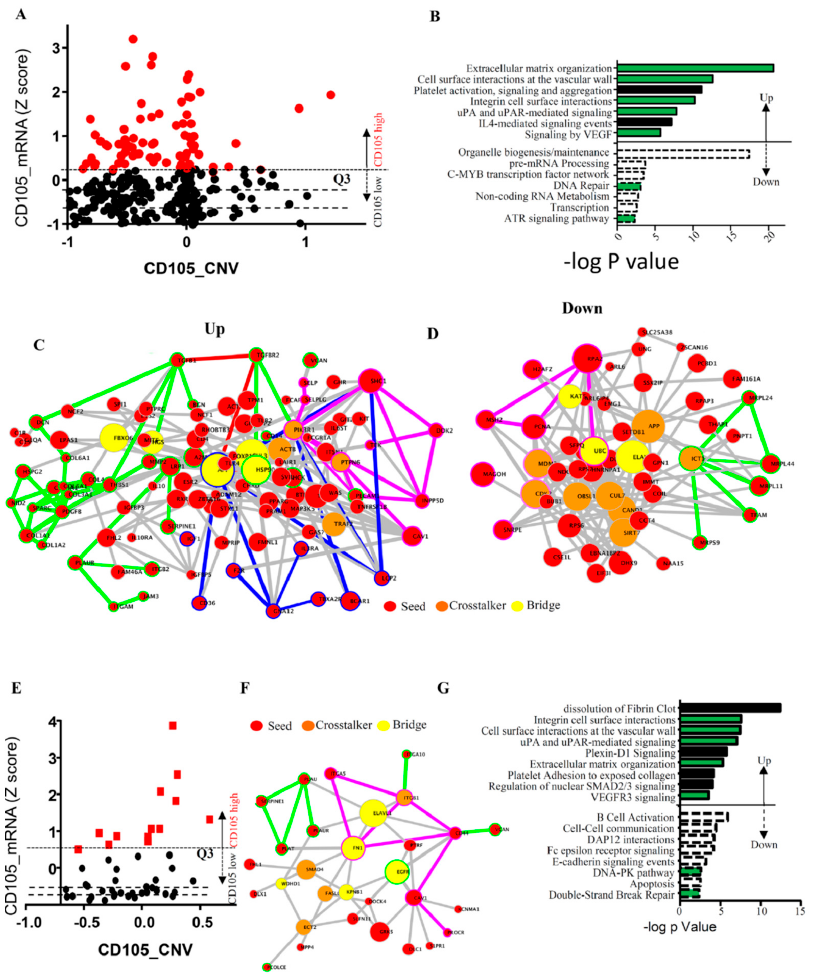
Figure 2. Functional protein interaction networks enriched in CD105-high ovarian cancer specimens and cell lines. ( A ) mRNA quantile distribution of CD105 expression in a 307-sample TCGA ovarian cancer RNA-Seq dataset (OVCA-TCGA, cBioPortal). Values at Q1–Q3 are indicated by dotted lines. CD105 high-expressing tumors are highlighted in red. ( B ) List of pathways enriched (Up) or reduced (Down) for CD105-high cells using Crosstalker network analysis (-log 10 p value). ( C – D ) Protein network enriched (C) or reduced (D) in CD105-high ovarian cancer samples. ( E ) mRNA quantile distribution of CD105 expression in ovarian cancer cell lines from the CCLE RNA-Seq dataset (OVCA-CCLE). Values at Q1–Q3 are indicated by doted lines. CD105 high-expressing tumor cells are highlighted in red. (F) Protein network enriched in CD105-expressing ovarian tumor cell lines. ( G) Significantly enriched or reduced pathway modules in the Crosstalker network analysis (-log 10 p value). Green bars represent common pathways enriched/downregulated in both TCGA and CCLE datasets. Seeds (in Red) represent input gene list. Bridge (Yellow) and Crosstalker (Orange) represent non-seed genes that are significant in the particular enriched network.